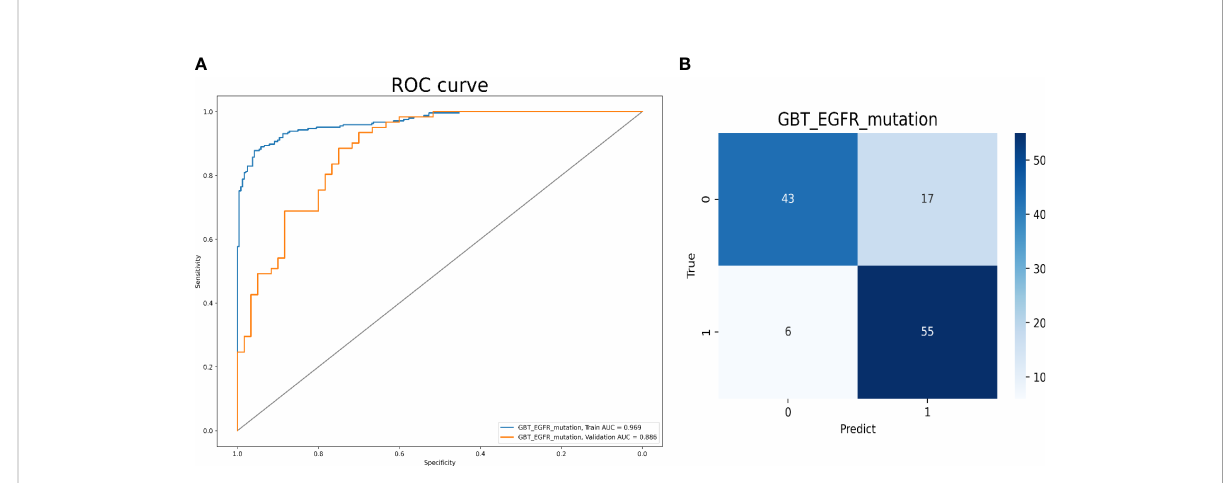
FIGURE 3 Model 1 validation. (A) The ROC curves for model 1 to identify positive and negative EGFR mutation cases. (B) The confusion matrix for model